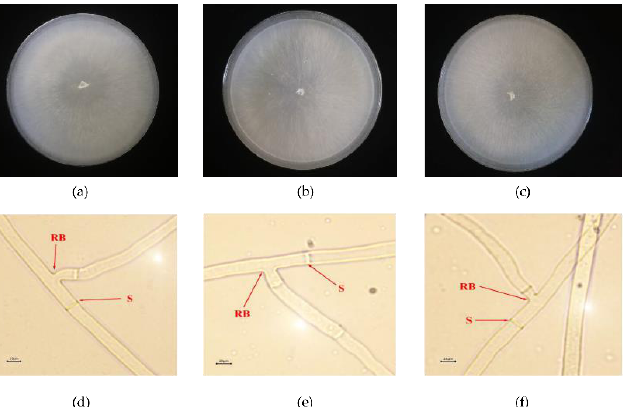
Figure 3. The mycelium morphological characteristics of three clades strains. ( a ) Community morphology of T12 (Clade A); ( b ) Community morphology of T9 (Clade B); ( c ) Community morphology of T13 (Clade C); ( d ) Mycelium morphology of T12 (Clade A); ( e ) Mycelium morphology of T9 (Clade B); ( f ) Mycelium morphology of T13 (Clade C). RB: Rectangular branch; S: Septum. The Petri dishes are 9 cm in diameter.